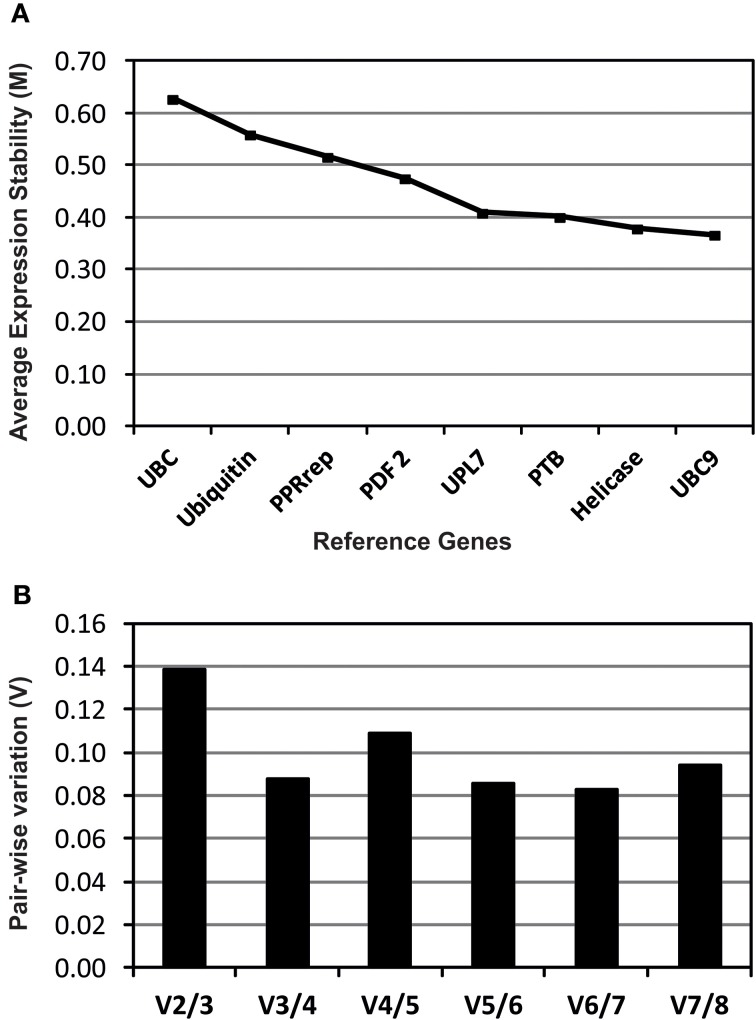
Evaluation of candidate reference genes analyzed using geNorm software. Expression stability (A) and pair-wise variation (B) plots for the eight reference genes studied. A lower M value indicates a more stable expression. The pair-wise variation (V) values indicate the optimal number of reference genes.